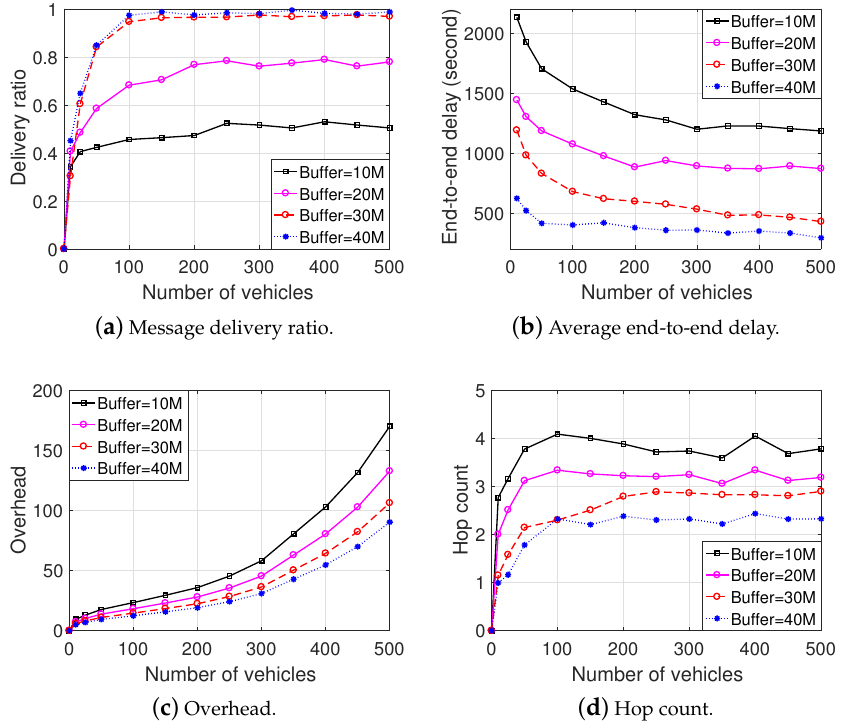
Figure 4. Network performance vs. buffer.